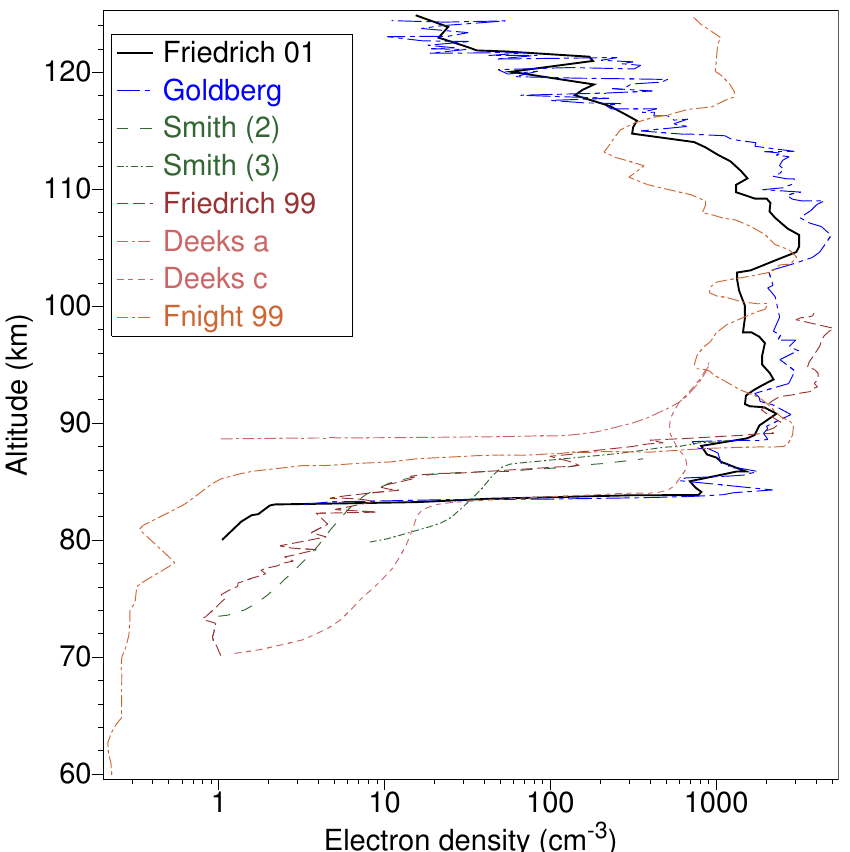
Figure 1. Nighttime electron densities as a function of altitude, measured by radio reflection (Deeks a,c) [1] and by rockets: (Friedrich 01) [4], (Goldberg) [5], (Smith (2,3)) [2] and (Fnight 99, Friedrich 99))